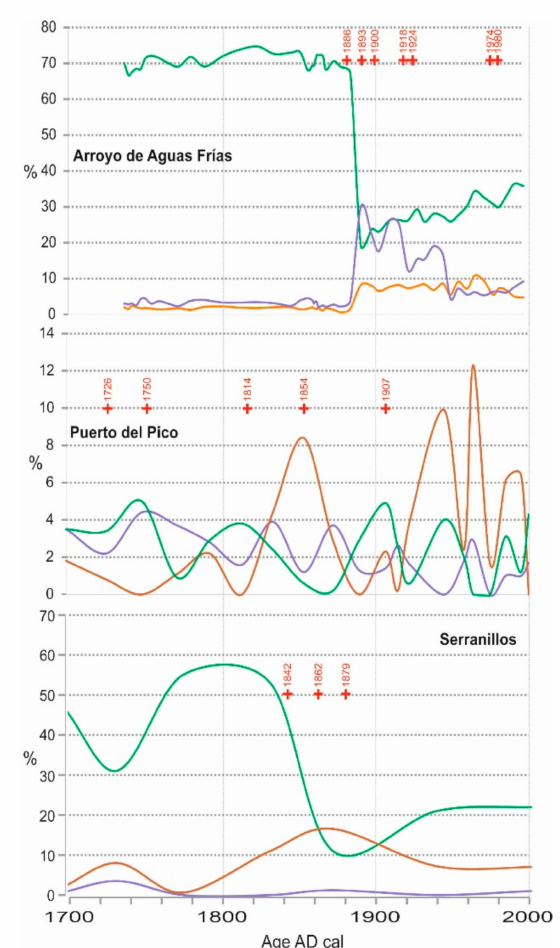
Figure 3. Percentage values of the main pollen and non-pollen palynomorphs morphotypes cited in the text (green line: Pinus sylvestris ; violet line: Genisteae; brown line: coprophilous fungi) and inferred fire events based on charcoal analyses (red crosses).